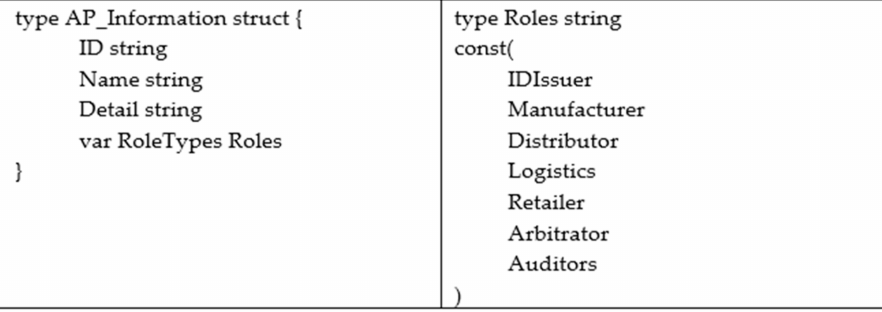
Figure 4. Chaincode structure of the access party and the enumeration of the role type.